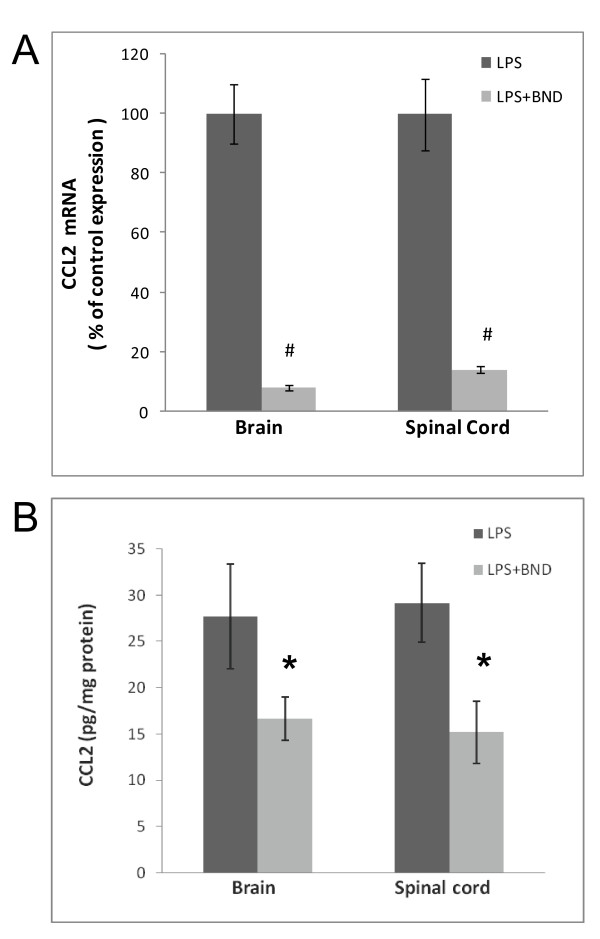
Bindarit’s effects on CCL2 mRNA and protein in brain and spinal cord following LPS. Mice received i.p. injection of 200 mg/kg bindarit (or vehicle) once a day for 4 days, followed by i.p. injection of 5 mg/kg lipopolysaccharide (LPS) at 30 minutes after the last bindarit treatment. At 4 hr after LPS injection, brain and spinal cord were prepared for CCL2 mRNA (A) and protein (B) determinations. LPS + bindarit-treated brain or spinal cord samples were compared to corresponding samples treated with LPS + vehicle (control). *P < 0.05; #P < 0.01.